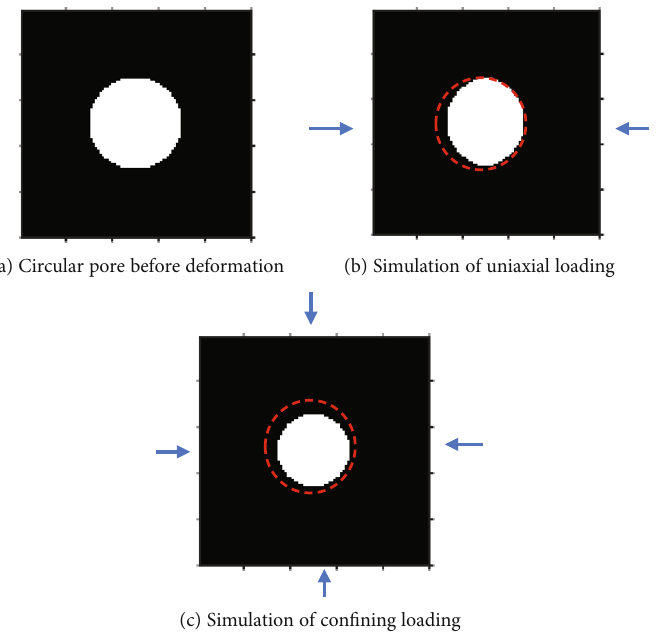
Figure 6: A schematic diagram of simulation deformation with the erosion method: the red dotted line in (b, c) indicates the pore edge before deformation, and the blue arrow indicates the loading direction.